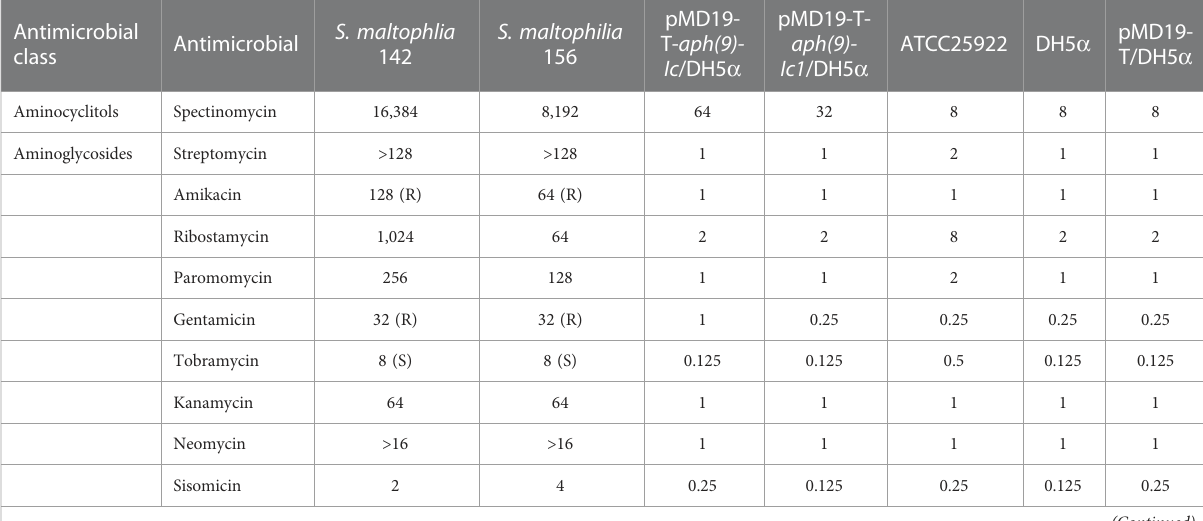
TABLE 3 MIC values of various antimicrobials for seven bacterial strains ( m g/mL).